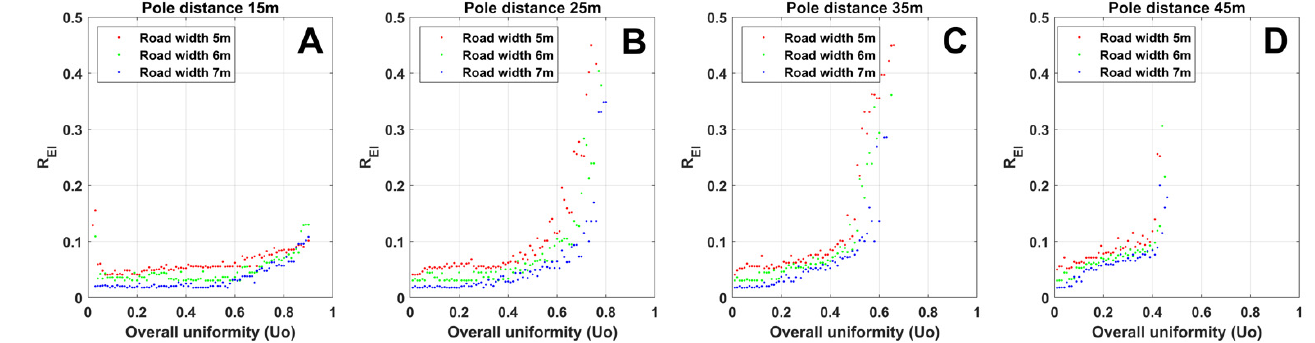
Figure 11. Overall uniformity of illuminance vs. minimum R EI for key pole distances. Only R EI ≤ 0.5 is included: ( A ) results for pole distance of 15 m; ( B ) results for pole distance of 25 m; ( C ) results for pole distance of 35 m; ( D ) results for pole distance of 45 m.